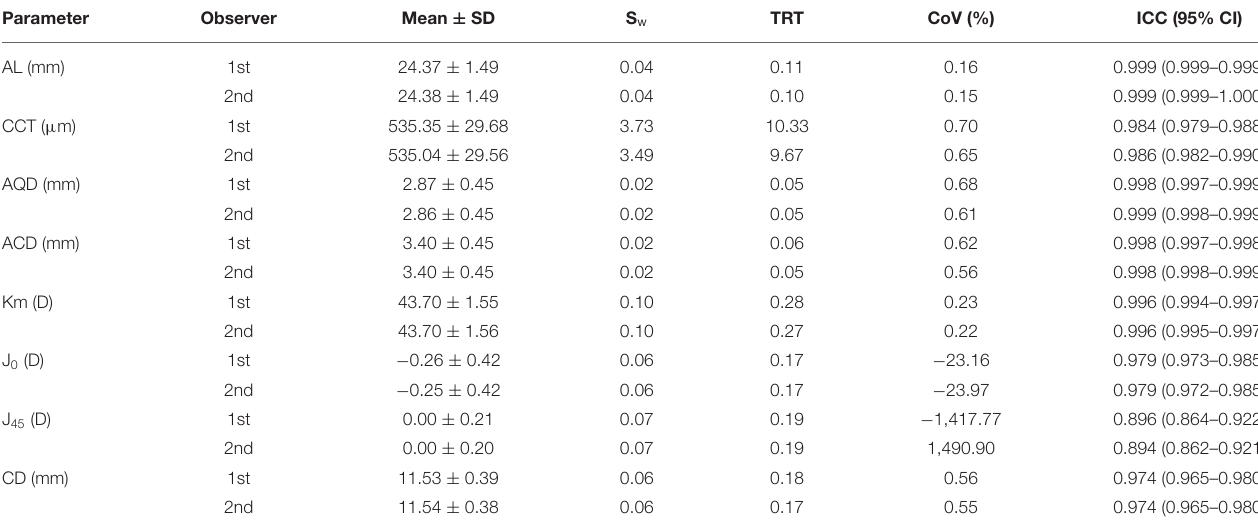
TABLE 1 | Intraobserver repeatability outcomes for biometric measurements obtained using the new Scheimpflug imager in combination with partial coherence interferometry biometer. Parameter